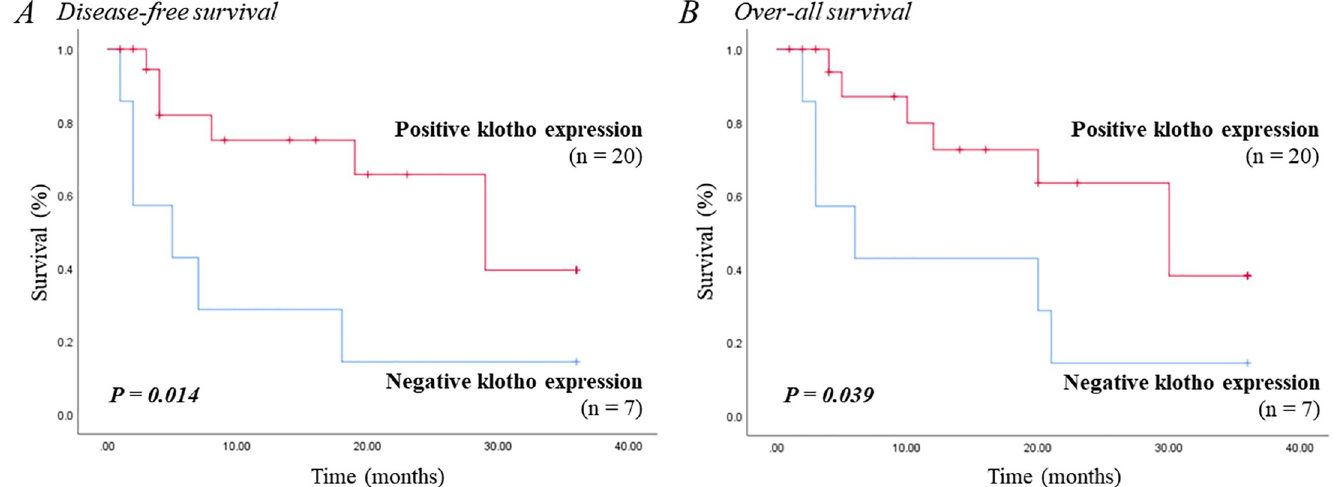
Fig 2. Kaplan–Meier survival curve of (A) disease-free survival and (B) overall survival based on the klotho expression of 27 dogs with malignant mammary gland tumor (median disease-free survival, 19 months; median overall survival, 21 months).